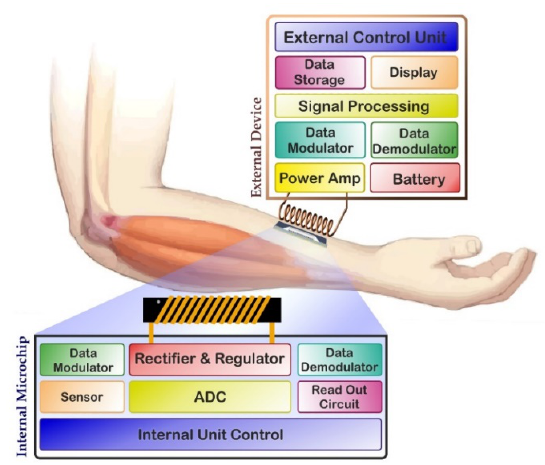
Figure 1. Simplified general block diagram of an Implantable Biomedical Microsystem (IBM).